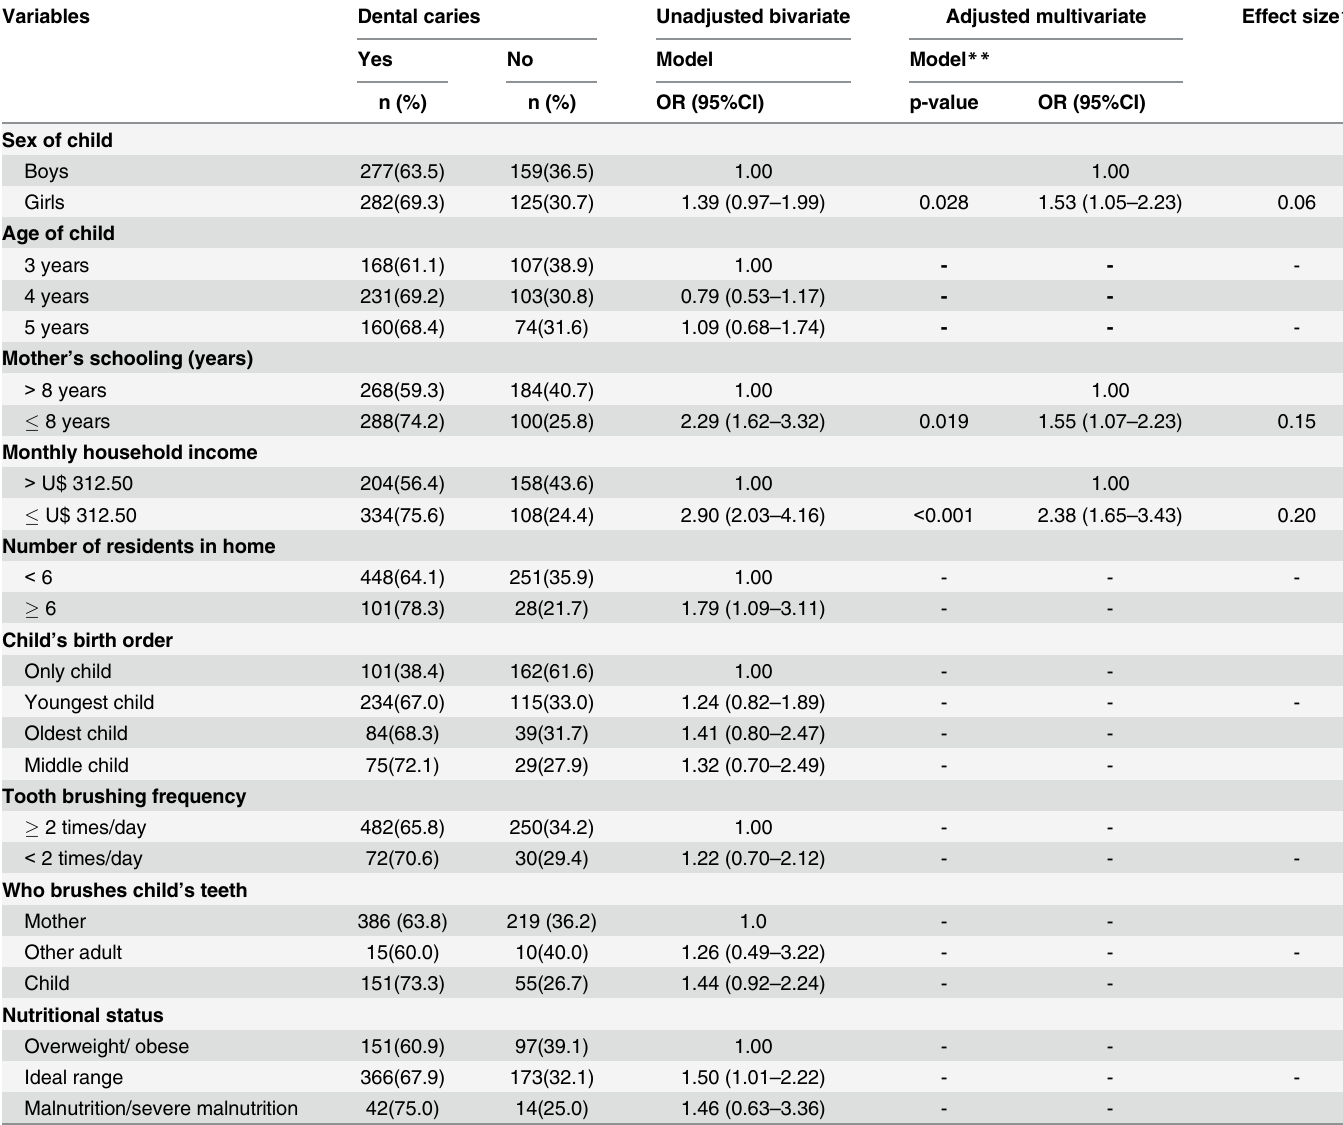
Table 2. Logistic regression model considering design effect (unadjusted and adjusted odds ratio) for dental caries and independent variables among children aged 3 to 5 years (OR, 95% CI).